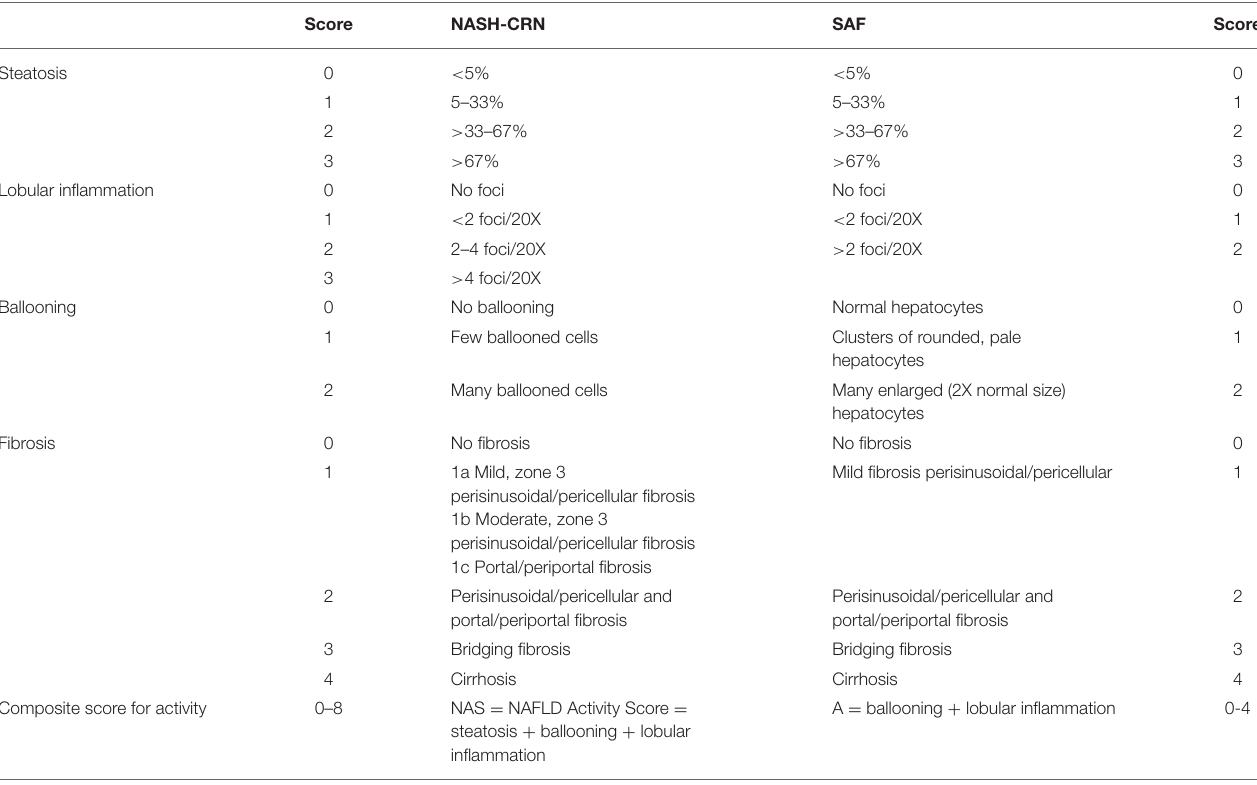
TABLE 1 | Comparison between the histologic scoring of NAFLD according to NASH CRN system and SAF system (18,